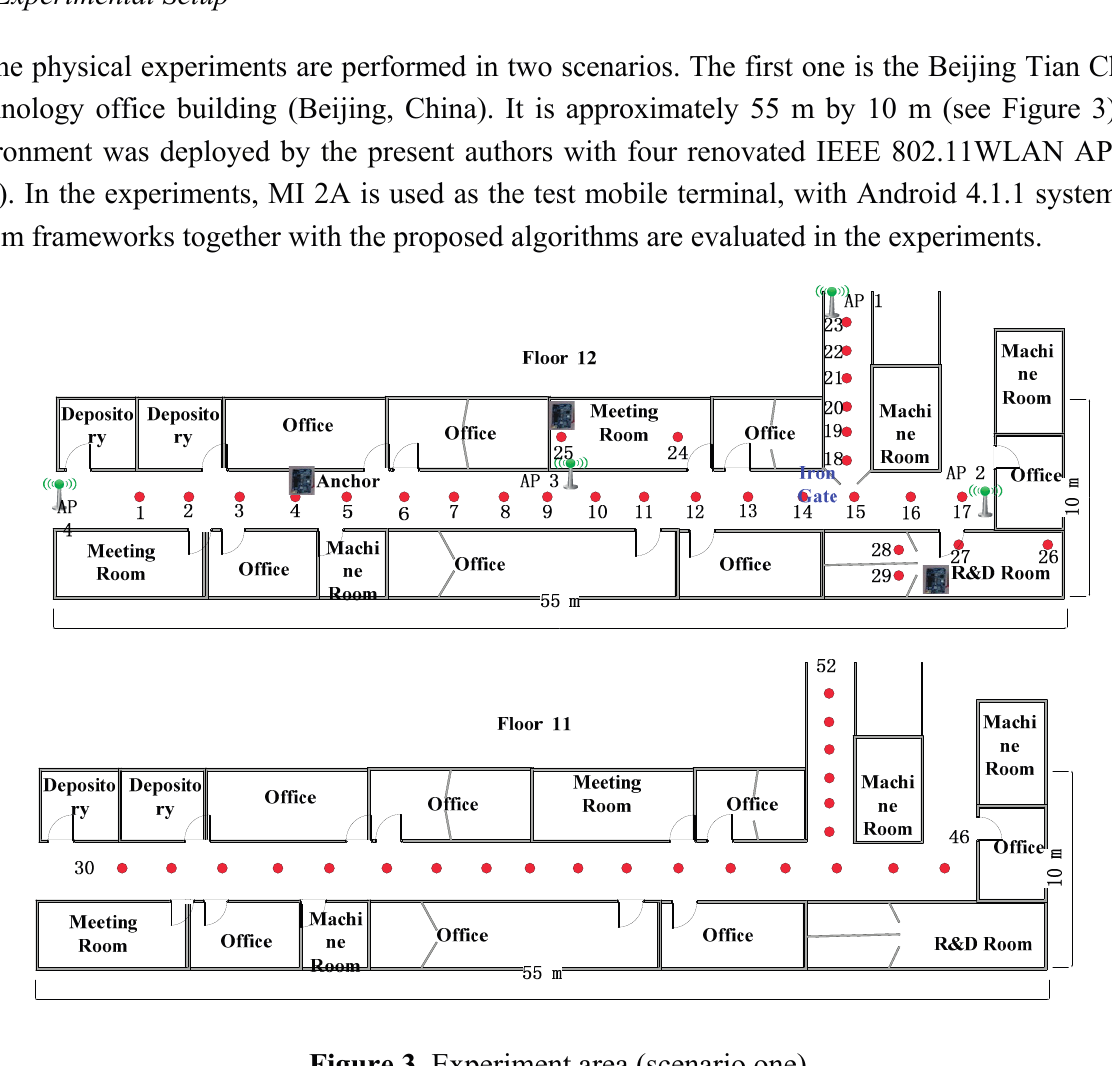
Figure 3. Experiment area (scenario